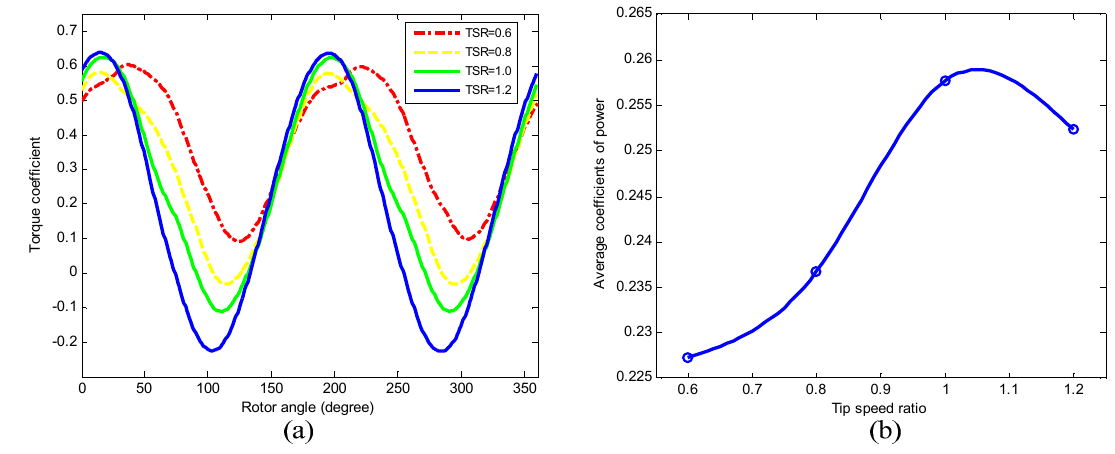
Figure 10. ( a ) Comparison of the torque coefficient at different rotor angle for the four TSRs ; and ( b ) average power coefficient at different TSRs .